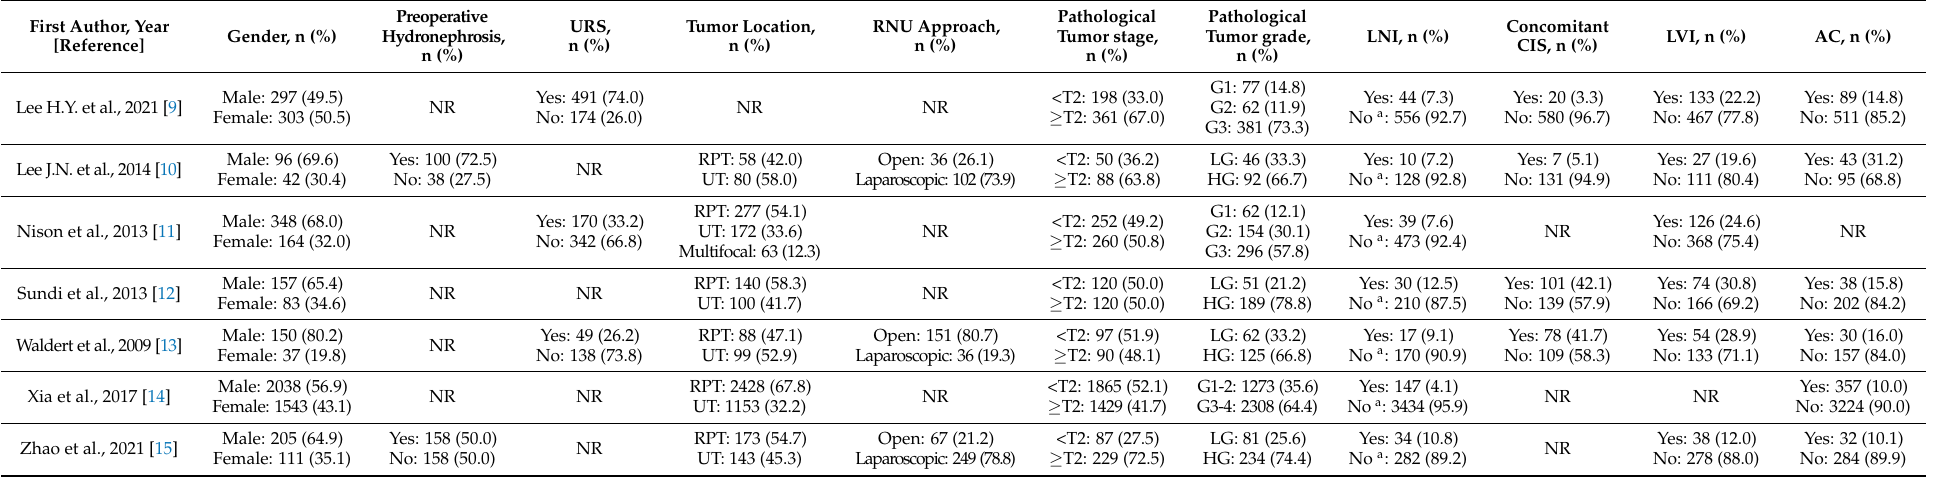
Table 2. Clinical and pathological characteristics of main cohorts in included